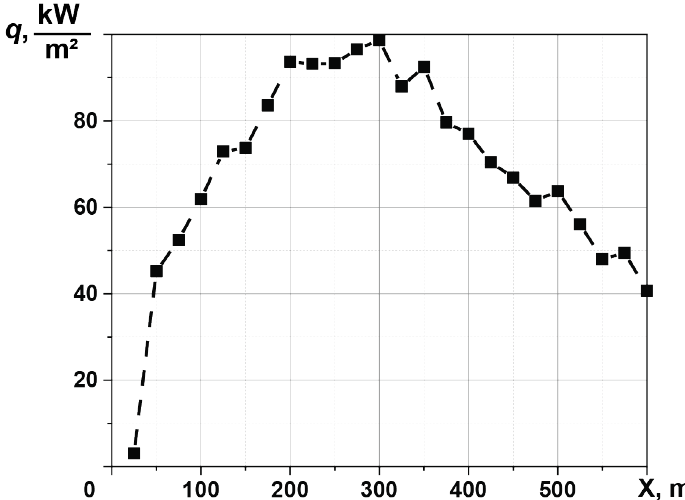
Figure 10. Local heat flux along the gas